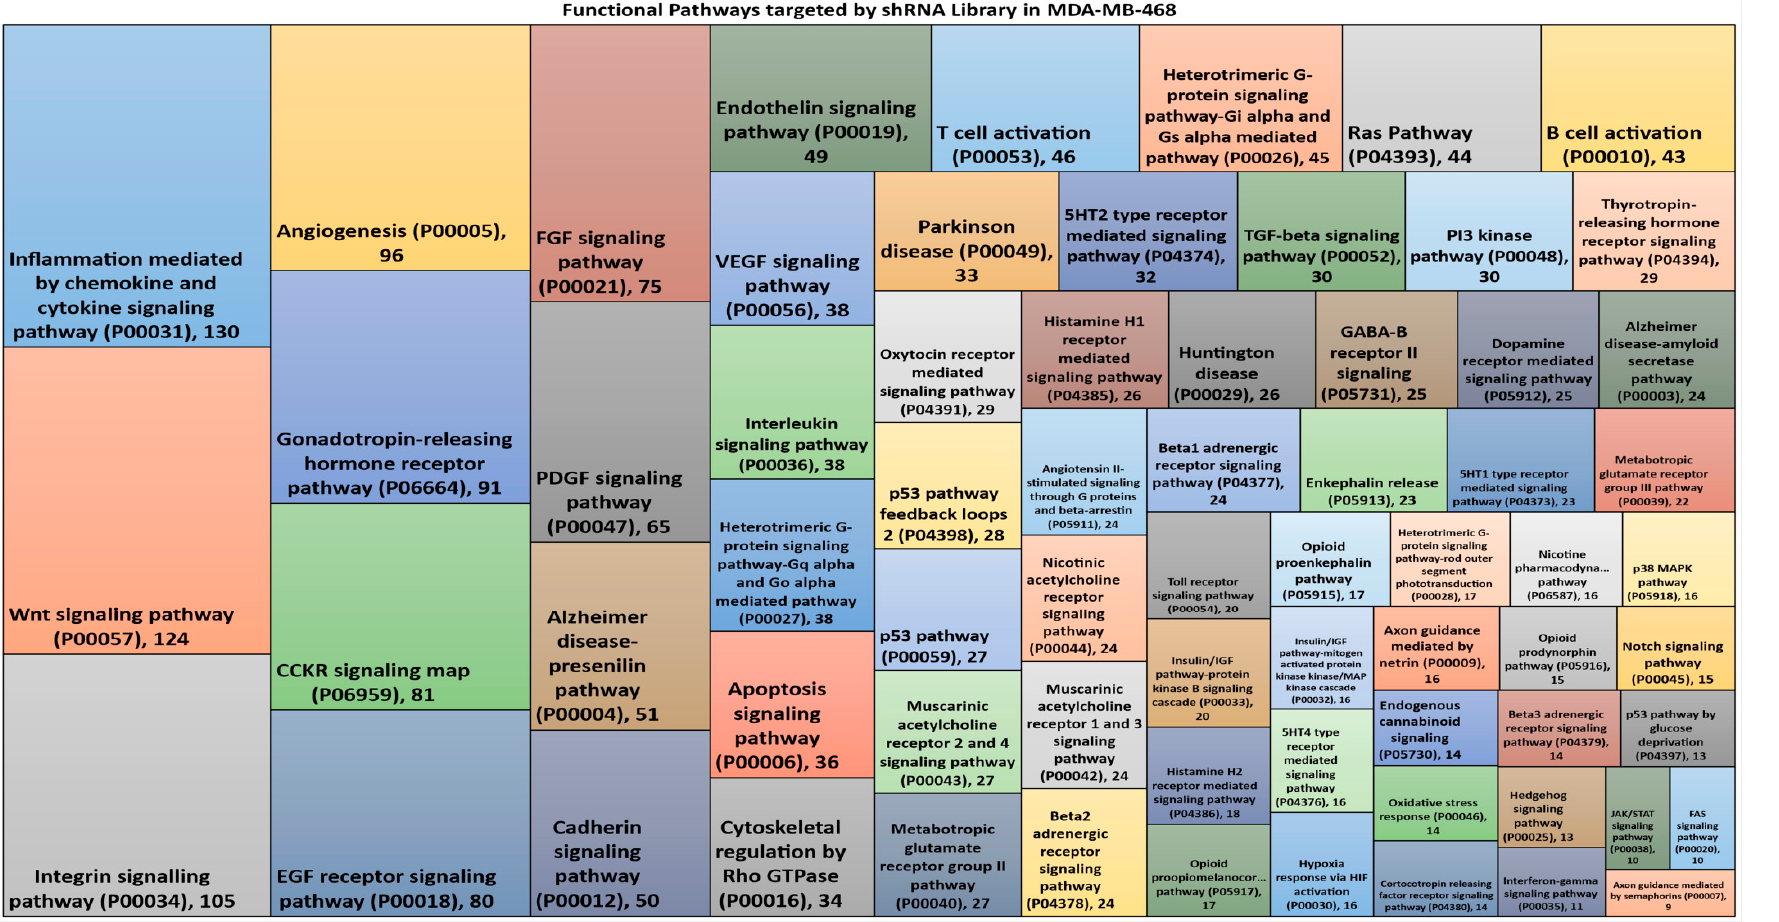
Figure 2. Gene ontology treemap representing the functional pathway enrichment from the genes targeted in the Polarity Pool-enriched hairpin library. The box size correlates to the total number of genes targeted by hairpins (also shown as the number within the box) belonging to the same functional pathway. Deduced hairpins targeting genes may well be represented in more than one pathway.